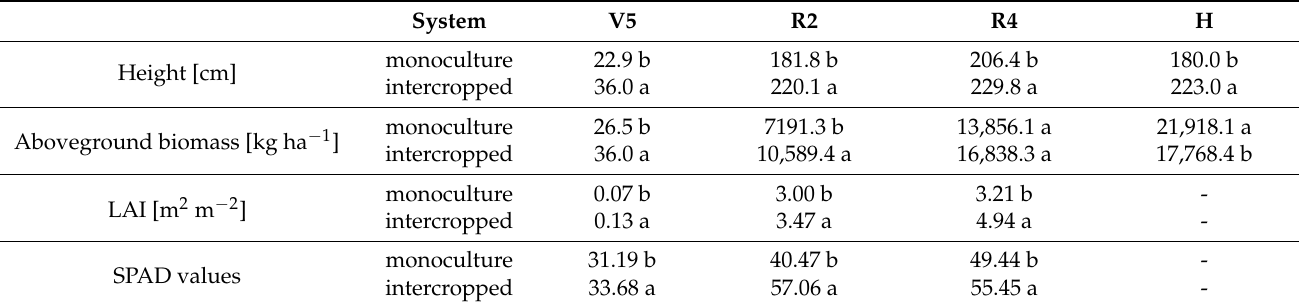
Table 3. Maize traits measured during: S—maize sowing date; V5—five leaves stage; R2—blister stage; R4—dough stage;